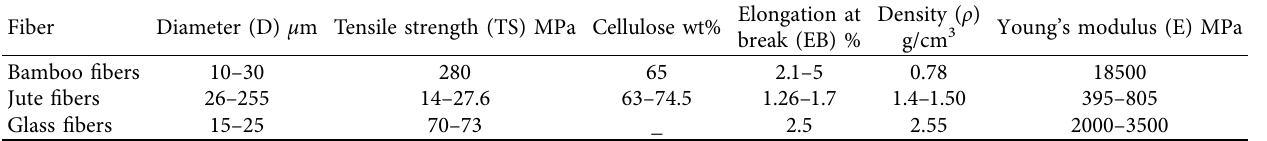
Table 1: Bamboo, jute, and glass fibers in comparison.